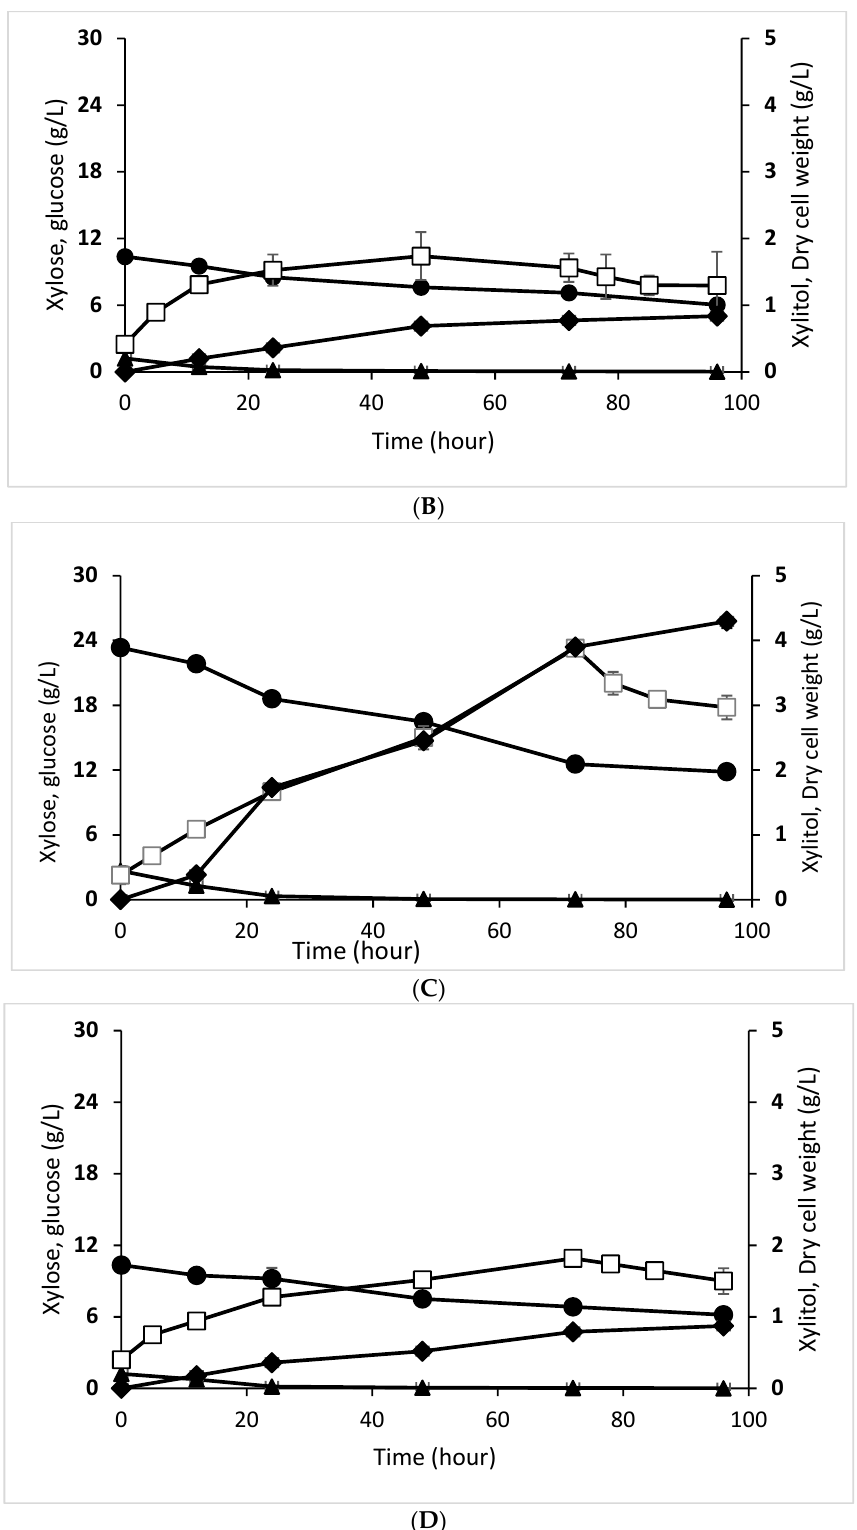
Figure 1. Xylitol fermentation profiles of D. hansenii in enzymatic hydrolysate ( A ), D. hansenii in acid hydrolysate ( B ), C. tropicalis in enzymatic hydrolysate ( C ), and C. tropicalis in acid hydrolysate ( D ). • Xylose concentration ( , closed circle), glucose concentration ( ▲ , closed triangle), dry cell weight ( □ , open square), xylitol concentration ( ♦ , closed diamond). The data are the means of three replicated investigations, and the error bars are standard deviations.